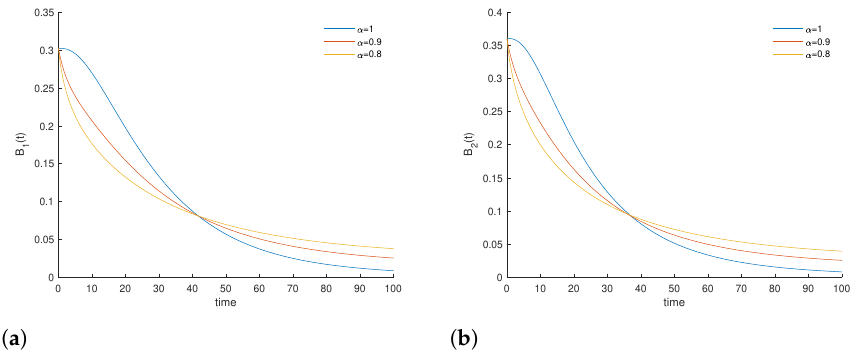
Figure 6. Variables B 1 and B 2 of the FOCP (8)–(13) with values from Table 1 and fractional order derivatives α = 1.0, 0.9 and 0.8. ( a ) Variation of vibrio population in 1st community; ( b ) Variation of vibrio population in 2nd